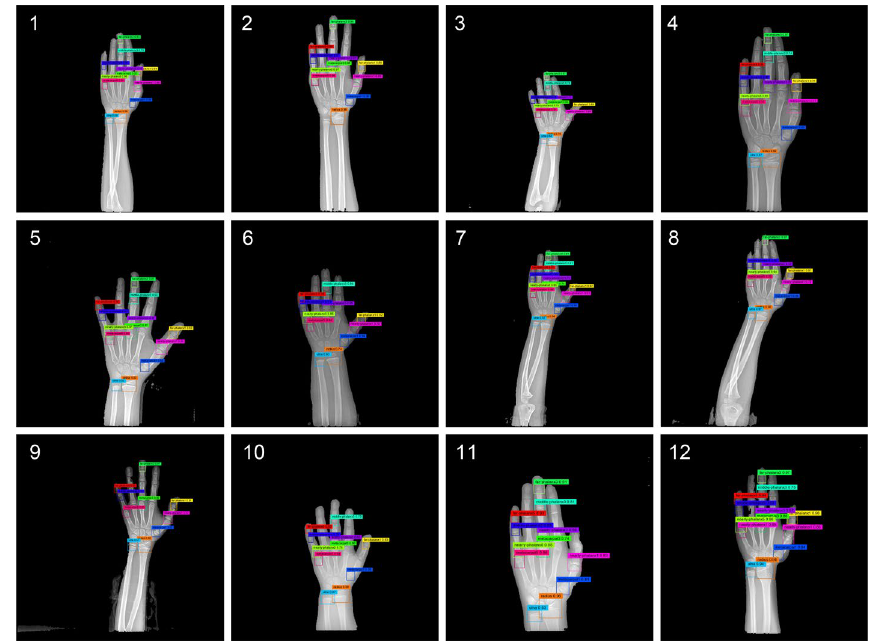
Fig. 13 Example outputs of ROIs detection in hand bone with YOLO. The labels of the bounding box, ROI name and AP are shown in the